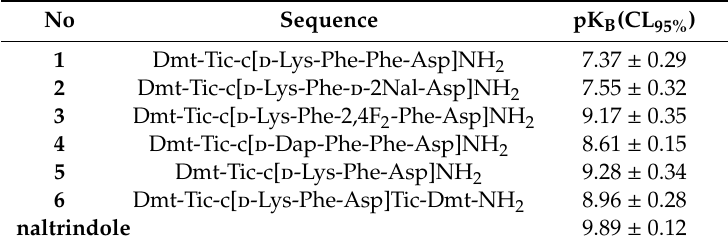
Table 3. Antagonist potencies (pK B ) of analogs 1 – 6 and naltrindole.